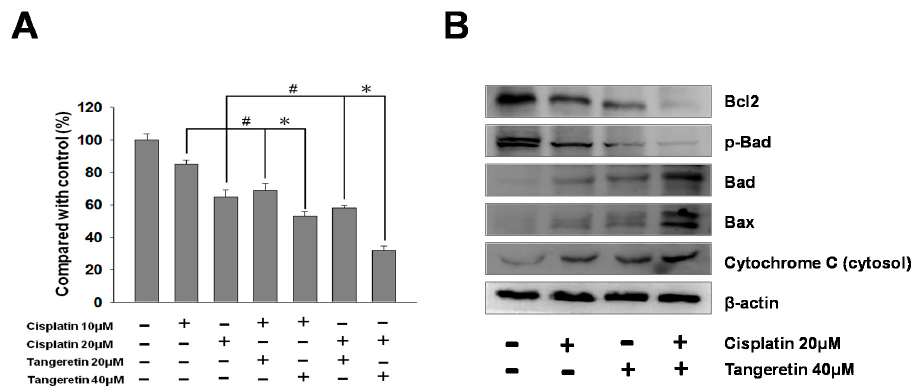
Figure 7. Cell survival of BFTC-905 bladder cancer cells after tangeretin and cisplatin treatment. ( A ) Cytotoxicity was measured using an MTT assay. # p < 0.05, * p < 0.001. ( B ) Validation of Bcl-2 family proteins by western blotting from BFTC-905 cells following tangeretin and cisplatin